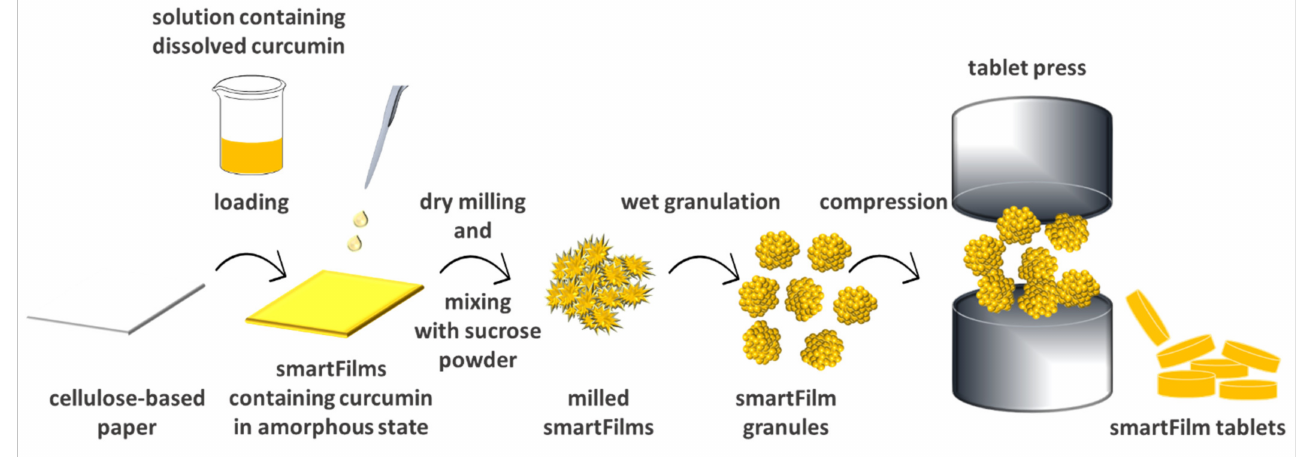
Figure 1. Scheme of production of curcumin-loaded smartFilm granules and smartFilm